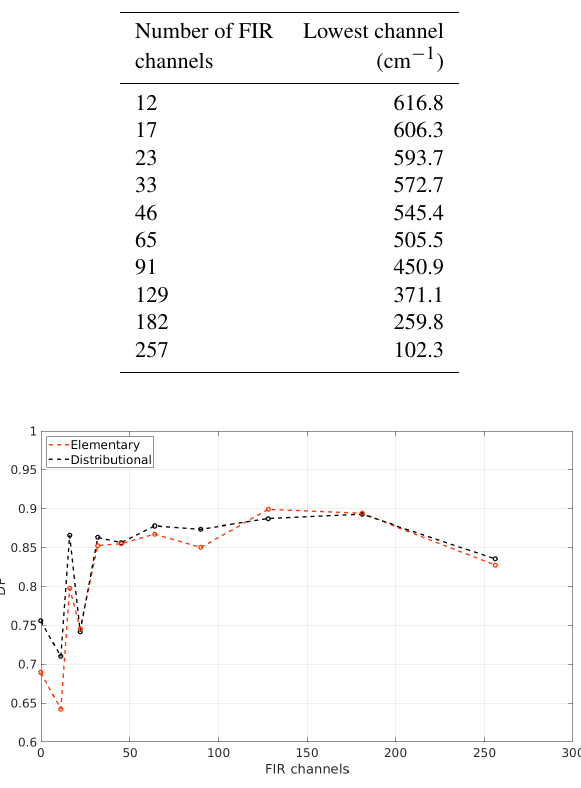
Figure 11. CIC cloud detection performance as a function of the number of FIR features (channels) for the tropical case. A total of 256 MIR channels are used. The black and red dots indicate the distributional and elementary approach,